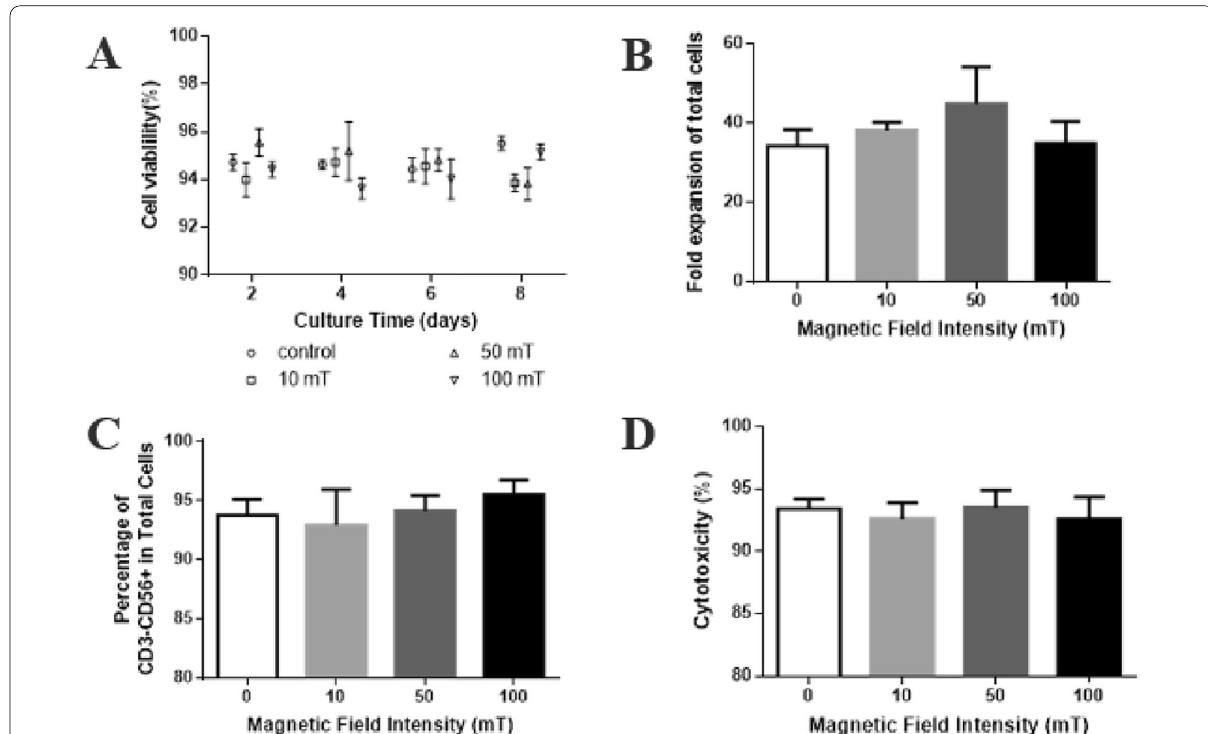
Fig. 3 Effect of static magnetic field on NK‑92 cells. A Fold expansion of total cells. B Cell viability. C Percentage of CD3 − CD56 + cells. D Cytotoxicity of the expanded NK‑92 cells. n =